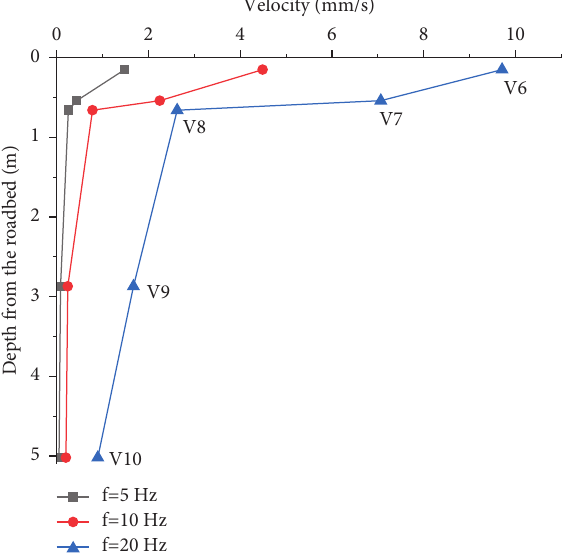
Figure 12: Distribution of vibration velocity in the vertical di- rection along with the depth from the roadbed